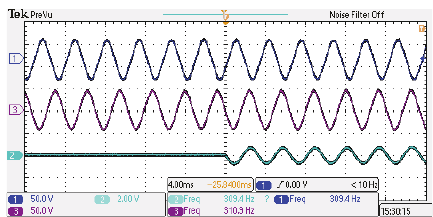
Figure 17: Measured short-circuit current and adjacent phase back- EMFs (4 ms/div, 50 V/div, 20 A/div, 50